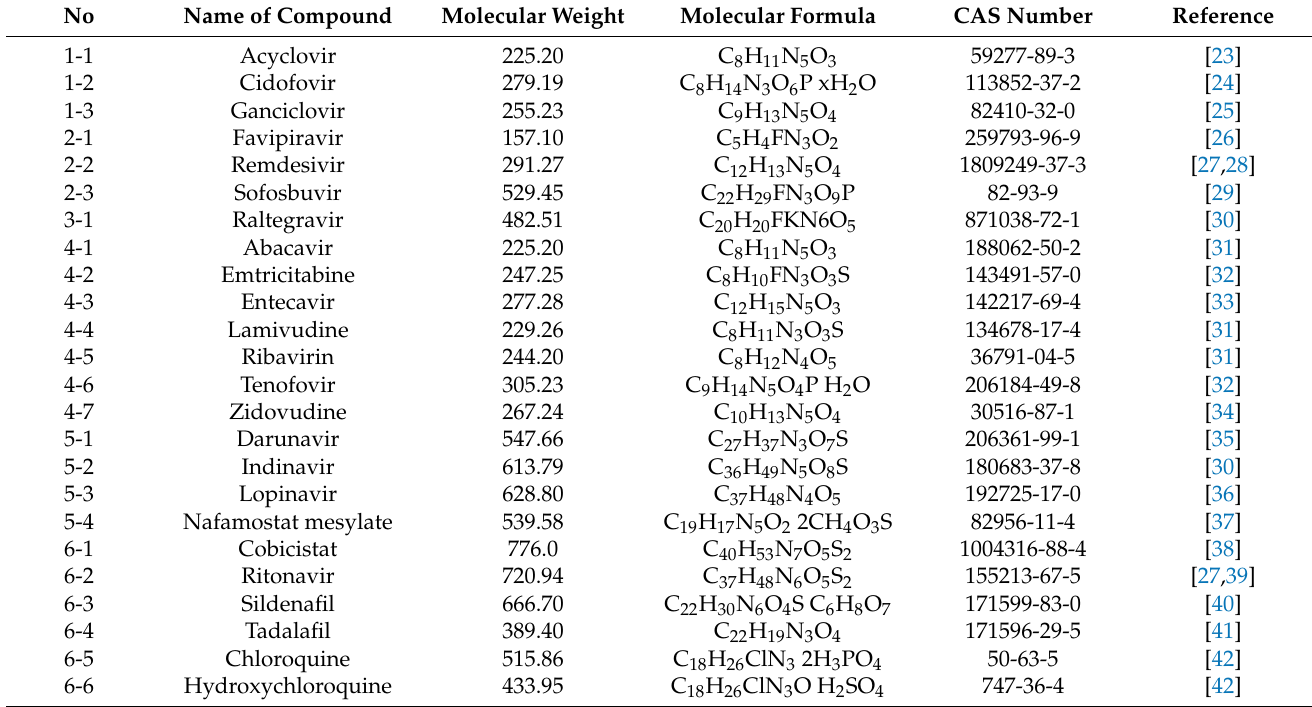
Table 1. A chemical library targeting viral enzymes.